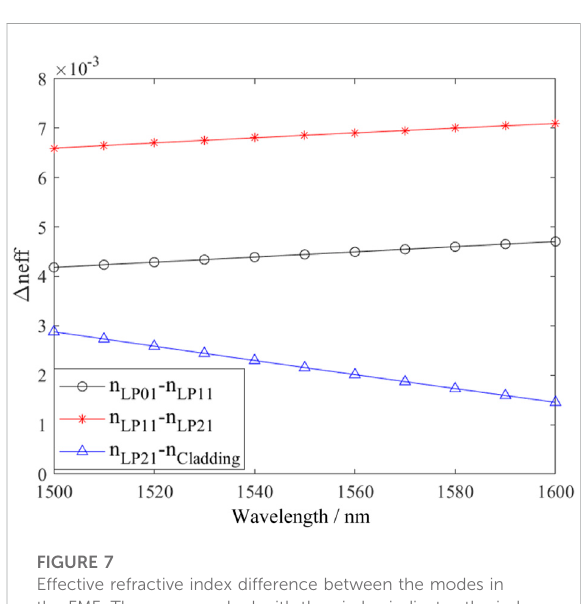
FIGURE 7 Effective refractive index difference between the modes in the FMF. The curve marked with the circles indicates the index difference between modes LP01 and LP11 n LP 01 − n LP 11 . The curve marked with the asterisks indicates the index difference between modes LP11 and LP21 n LP 11 − n LP 21 . The curve marked with the triangles indicates the index difference between mode LP21 and cladding n LP 21 − n Cladding